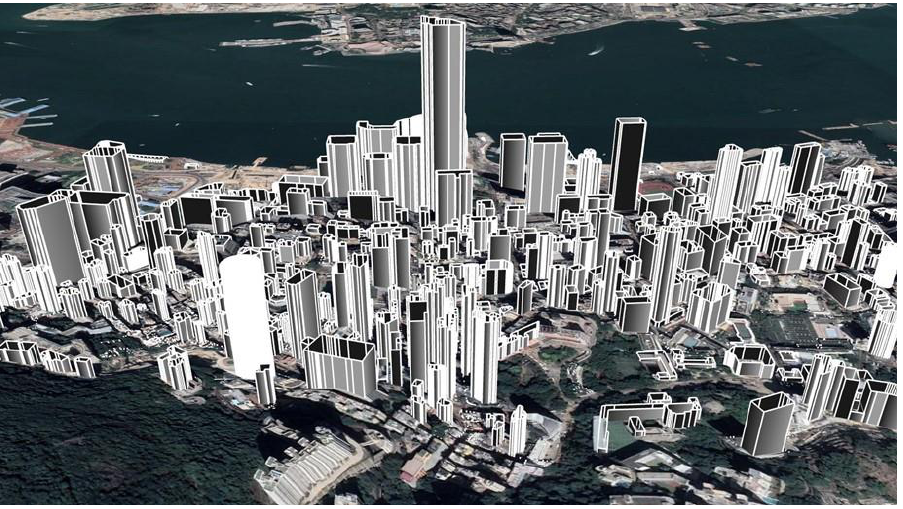
Figure 2. 3D building models of tested area. 232